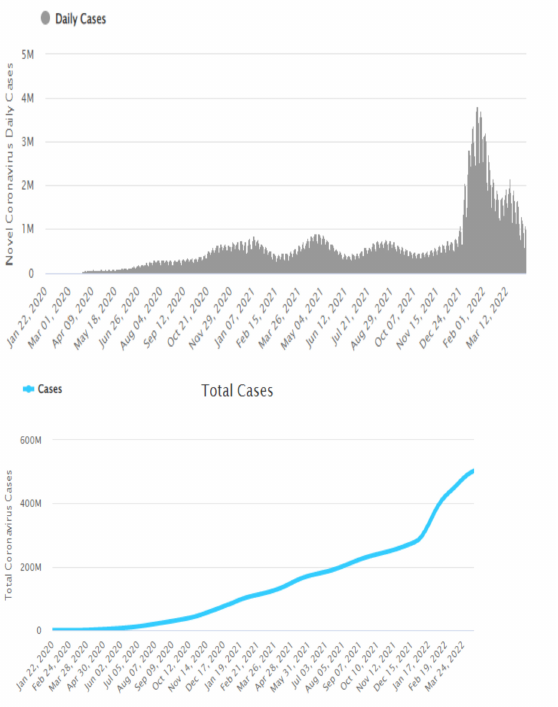
Figure 1. Global statistical report for COVID-19 (to Mar 2022)—world